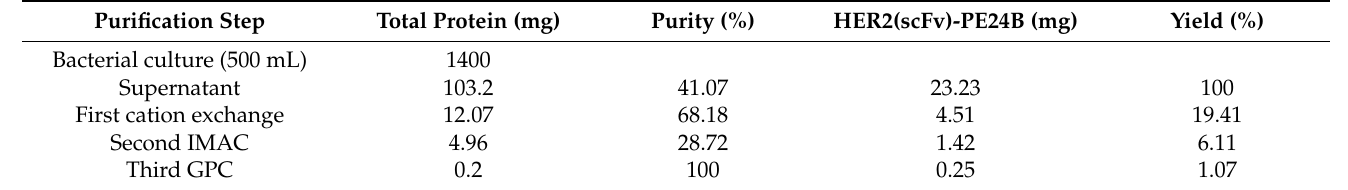
Table 1. Purification of HER2(scFv)-PE24B expressed in E. coli